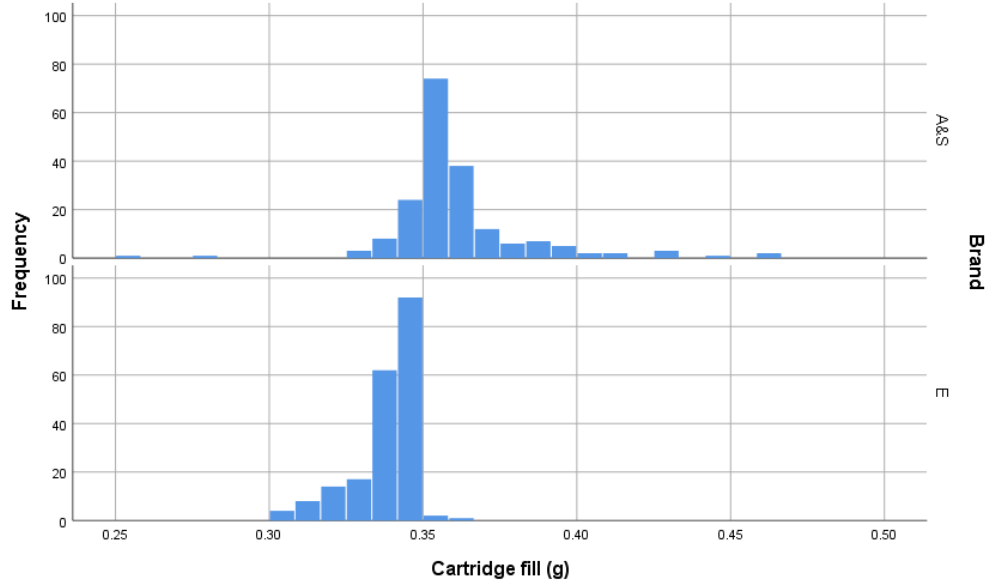
Figure 13. Plot of propellant fill in grammes, calculated by subtracting the mass of the post firing and cleaned cartridge cases from the pre-firing mass.